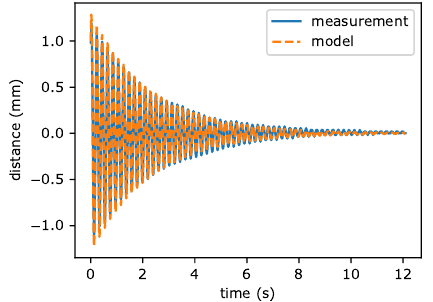
Figure 6. The example of model and measurement transients.